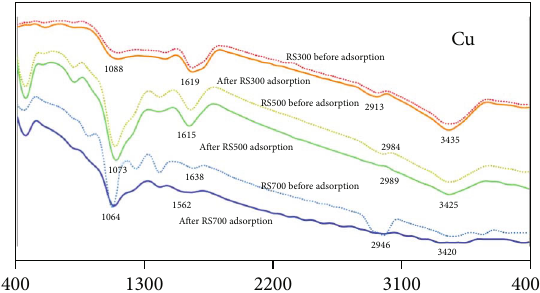
Figure 17: Competitive adsorption mechanism of Cu 2+ in acid solution of straw.